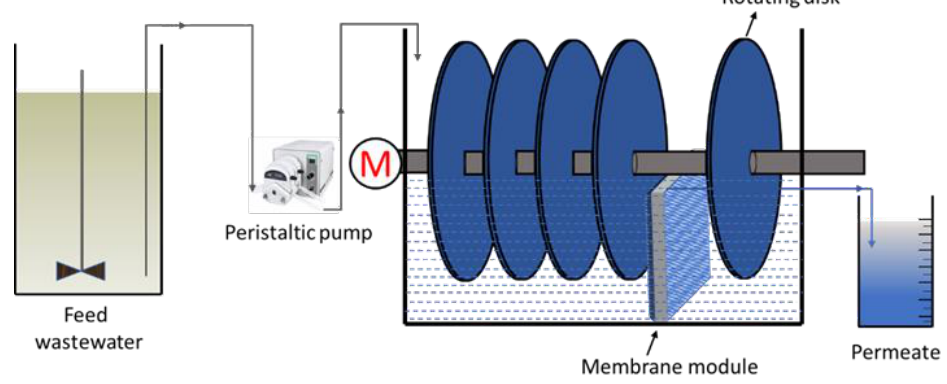
Figure 1. Schematic diagram of the membrane rotating biological contactor configuration.